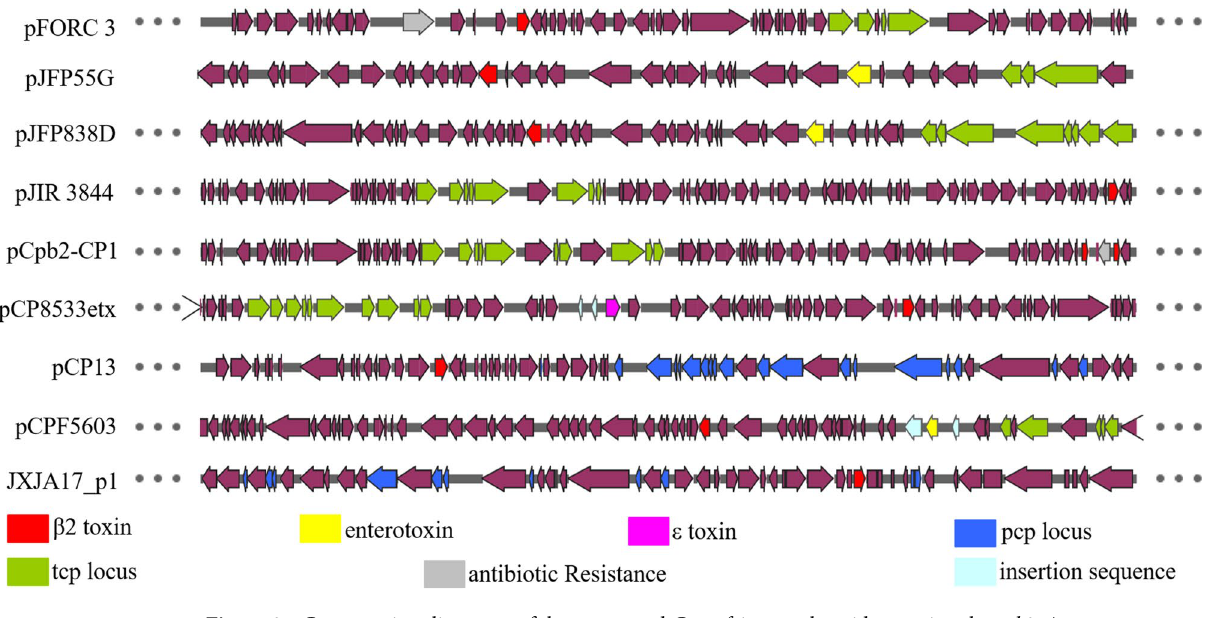
Figure 3. Comparative alignment of the sequenced C. perfringens plasmids carrying the cpb 2. Arrows represent ORFs, and are colored as follows: red arrows— cpb2 ; yellow arrows— cpe ; fuchsia arrows— etx ; dark blue arrows—Pcp conjugation locus; green arrows—Tcp conjugation locus; gray arrows—antibiotic resistance; light blue arrows—insertion sequence. ORFs open reading frames.